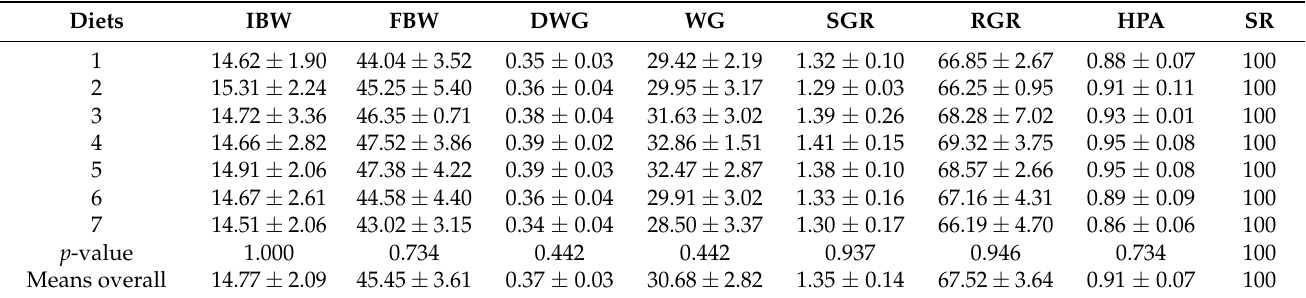
Table 3. Growth parameters (mean ± standard deviation, SD) after 12 weeks of feeding with control (0%BSFLM and 100% FM, and FM replaced at 10%, 20%, 40%, 60%, 80%, and 100% of the BSFLM.